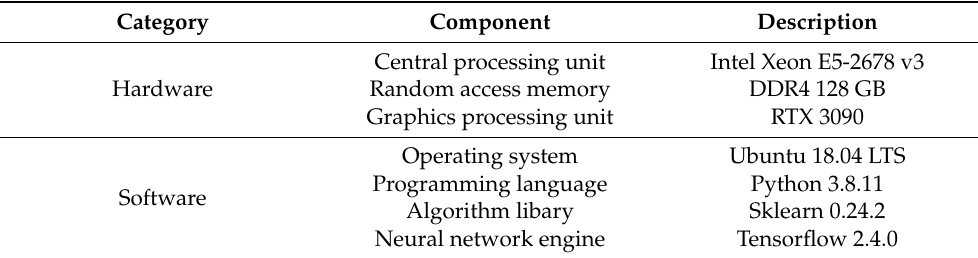
Table 2. Hardware and software settings in our